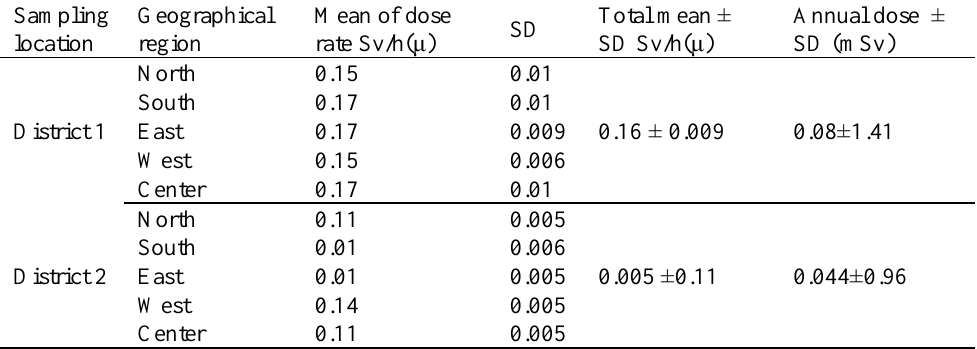
Table 1. Mean annual dose in closed space of public schools of districts one and two of Hamadan Sampling location